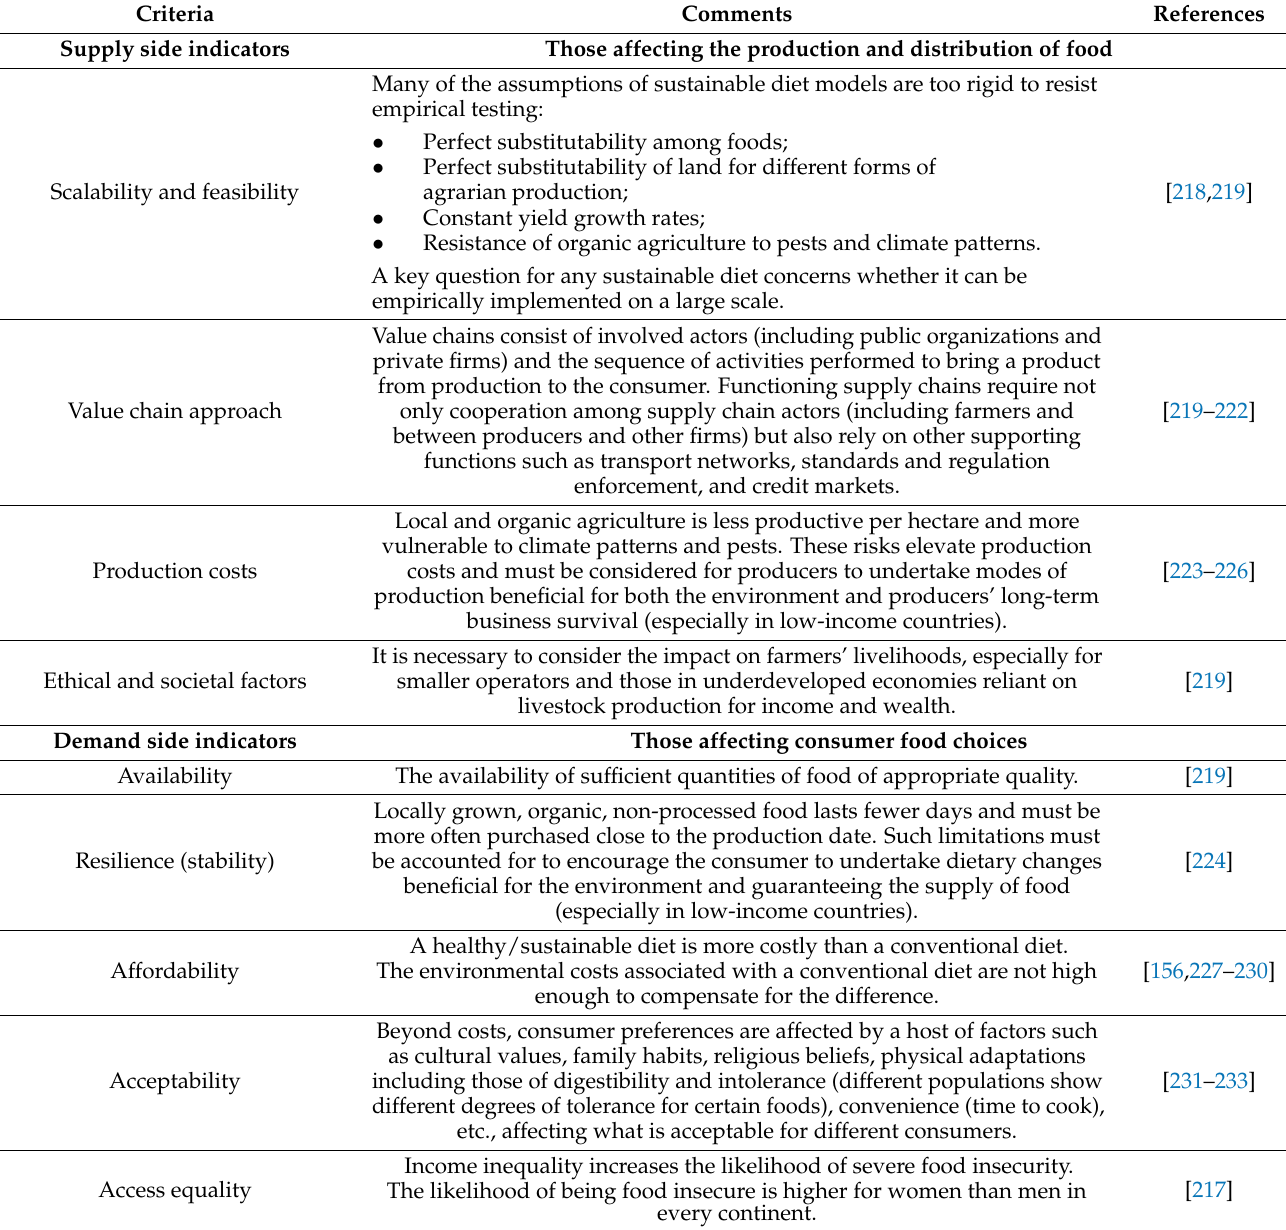
Table 4. Socioeconomic indicators for a sustainable healthy